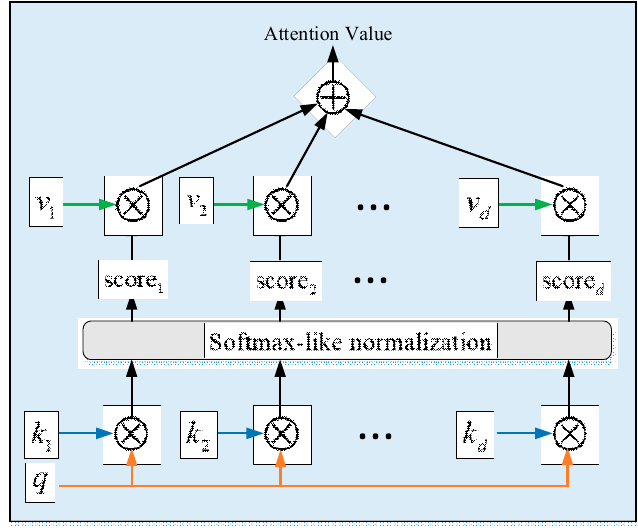
Figure 2. Schematic of an attention mechanism.